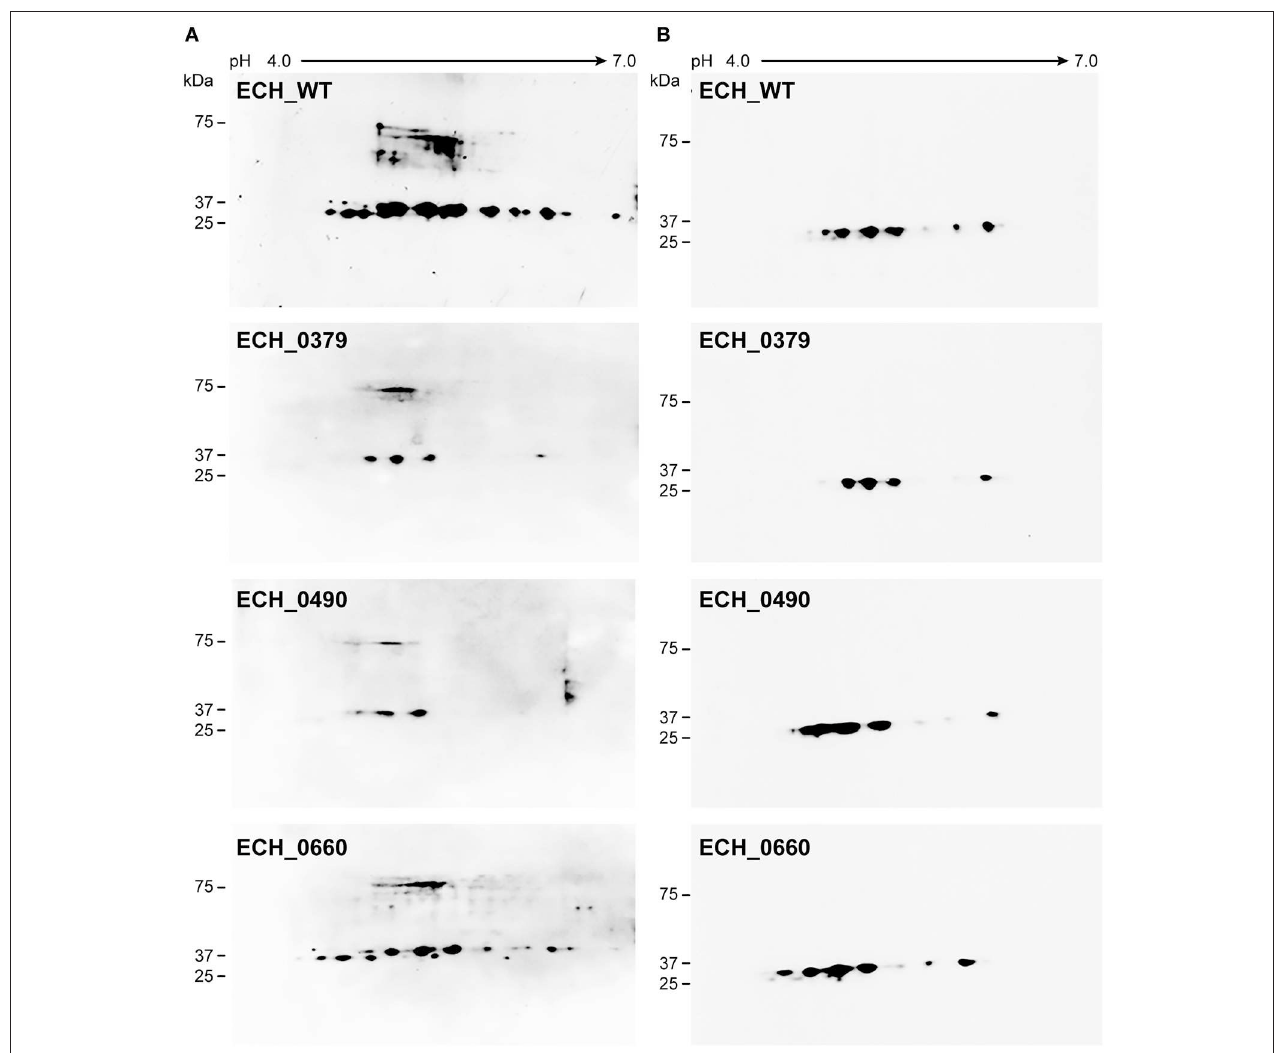
FIGURE 3 | E. chaffeensis wildtype and mutants’ proteins immunoblotted with polyclonal sera or with p28 monoclonal. One hundred µ g of proteins each were separated on 11cm, pH 4–7 linear IPG strips, and SDS-PAGE was performed using 4–20% Criterion gels. The resolved proteins from gels were transferred to nitrocellulose membranes and subjected to Western blot analysis with E. chaffeensis polyclonal sera (A) or with p28 OMP monoclonal antibody (B)